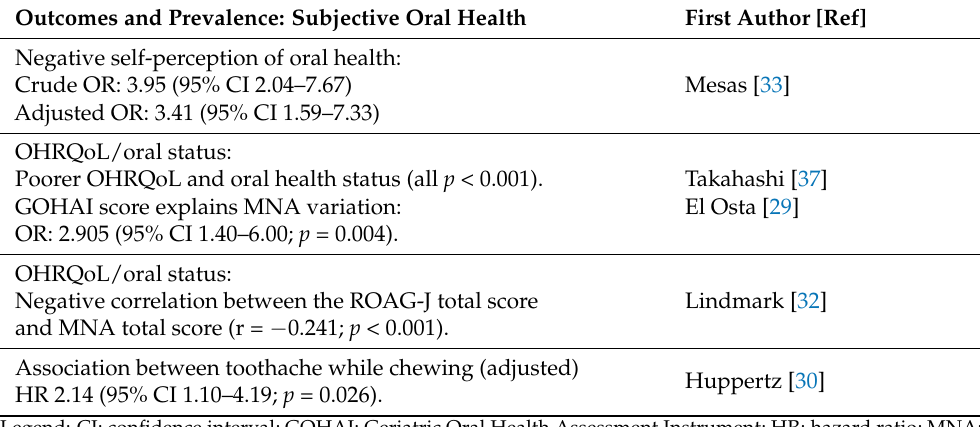
Table 5. Outcome measures regarding subjective oral